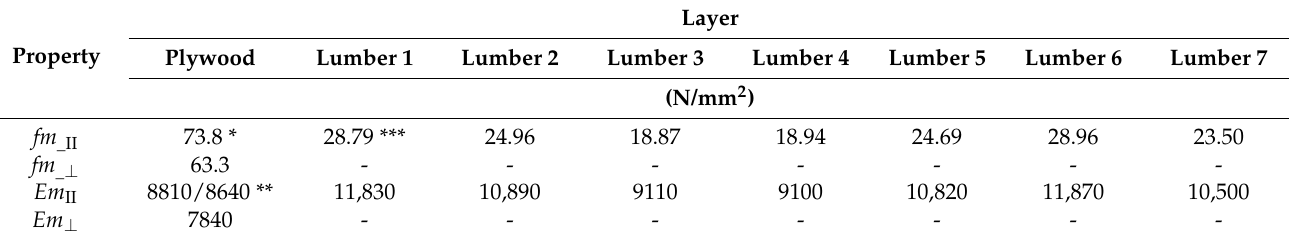
Table 1. Material properties for beams containing plywood